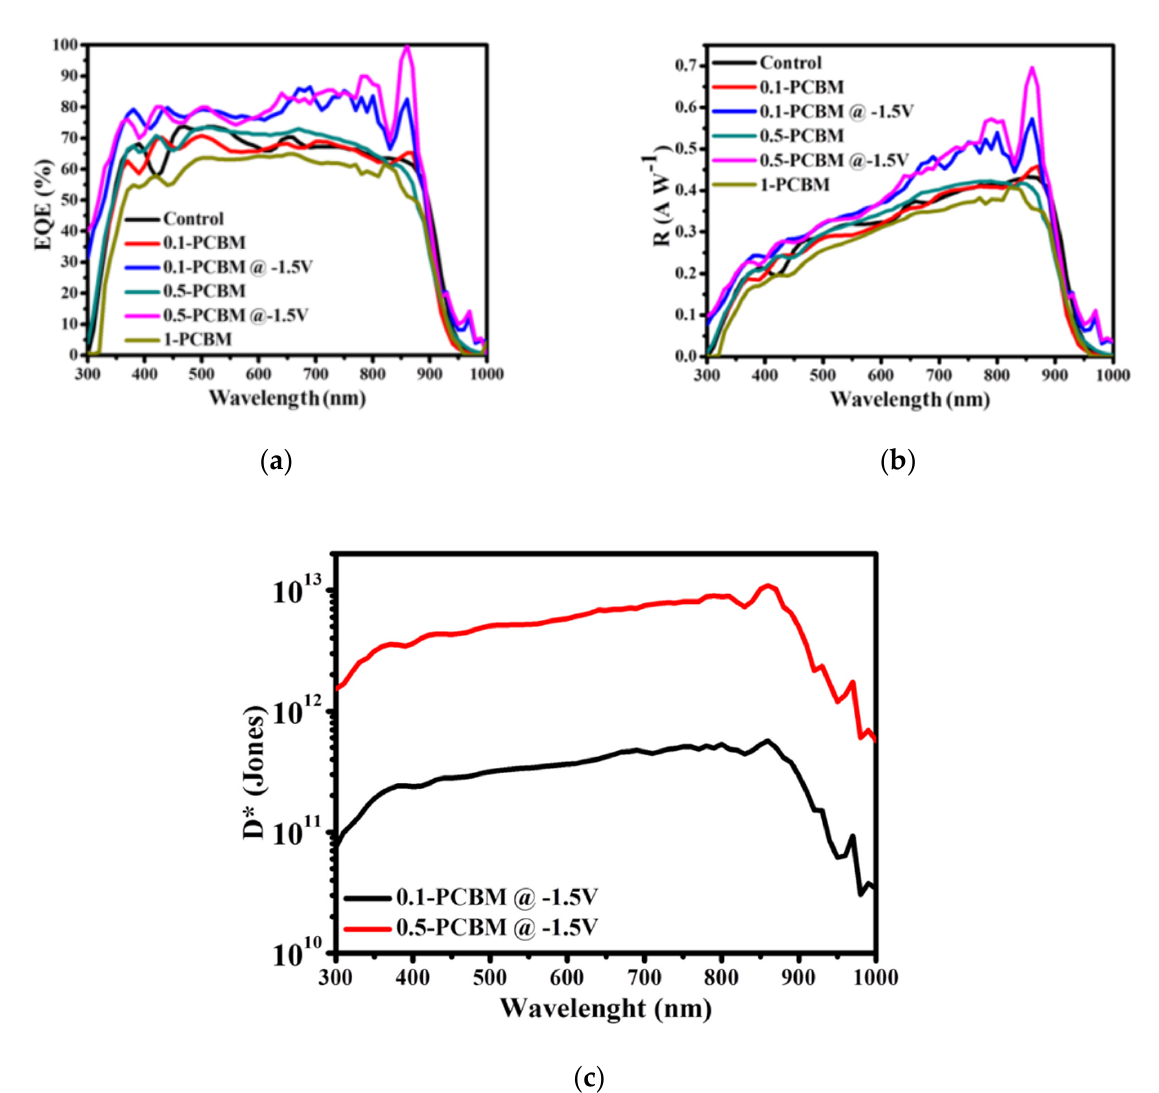
Figure 5. ( a ) EQE responses and ( b ) responsivity curves of the OPDs at biases of 0 and − 1.5 V. ( c ) Plots of D* for the 0.1–PCBM and 0.5–PCBM OPDs at a bias of − 1.5 V.